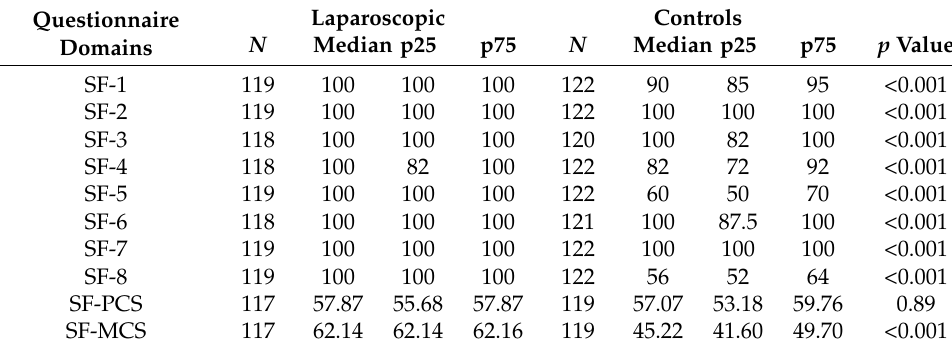
Table 4. Comparison of SF-36 scores between two